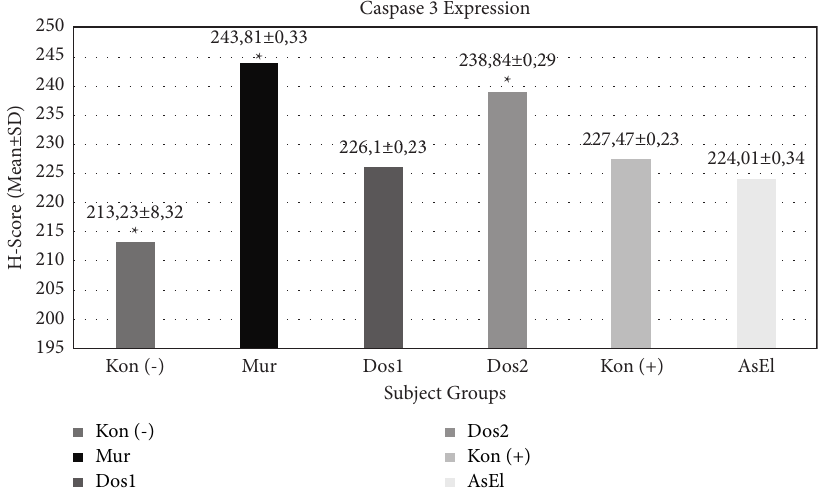
Figure 4: The caspase-3 expression in mice crypt cells is indicated by the H-score. Data are presented in the form of mean ± standard deviation ( N � 33). Kon( − ) was the DSS group, Mur was the normal group, Dos 1 was dose 1: pomegranate peel extract of 240mg/kg/day, dose 2 (Dos 2) was the pomegranate peel extract of 480mg/kg/day, Kon (+) was aspirin, and AsEl group was treated with aspirin and pure ellagic acid. ∗ Significant differences with the DSS group ( p < 0 . 05 ) ; ∗∗ no significant differences among dose 1, ASP, and ELA. DSS group, (NORM): normal group, dose 1 (Dos 1): pomegranate peel extract of 240mg/kg/day, dose 2 (DOS2): pomegranate peel extract of 480mg/kg/ day, ASP: aspirin, and ELA: pure ellagic